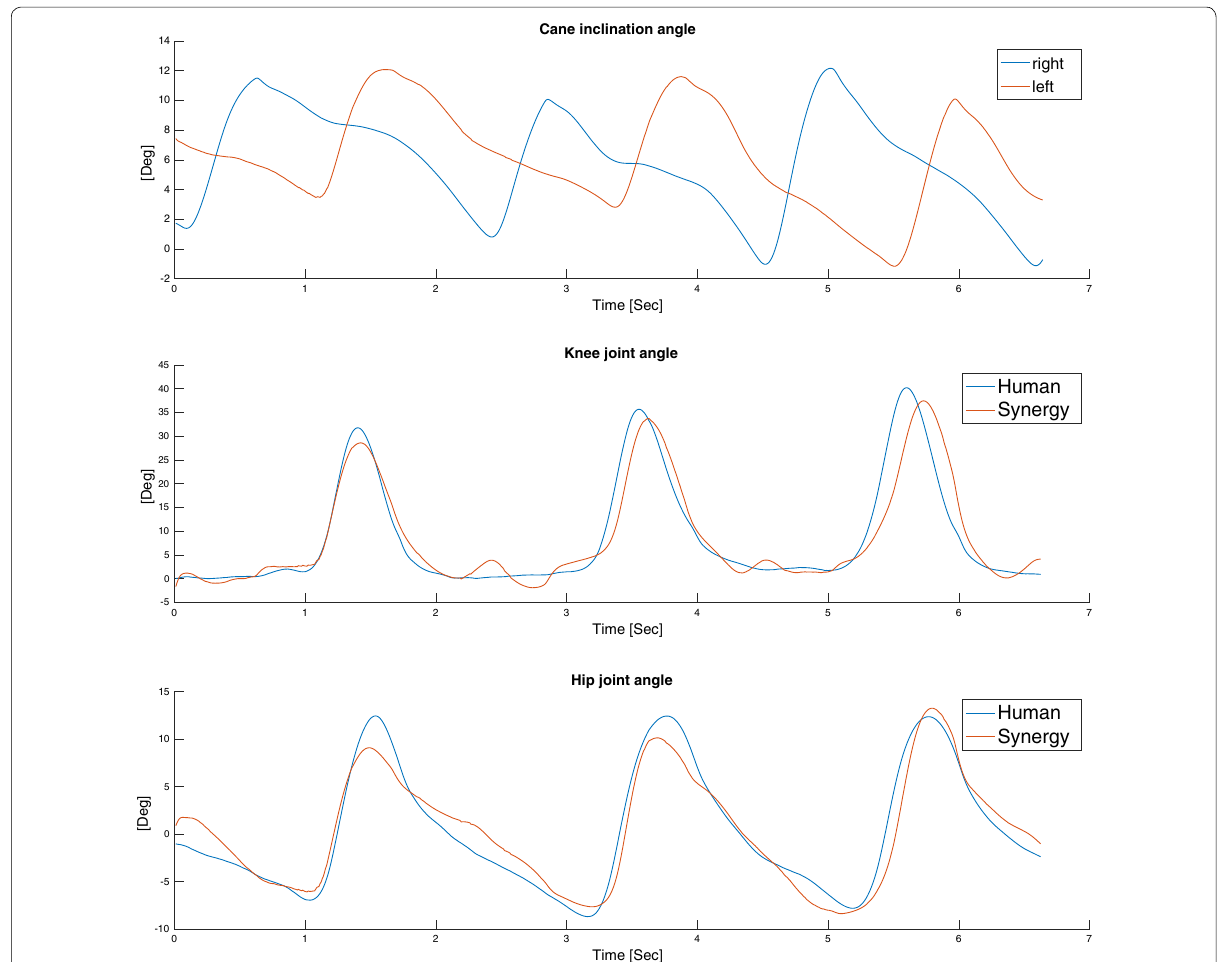
Fig. 1 Comparison between human walking joint trajectory and walking joint angles generated using walking